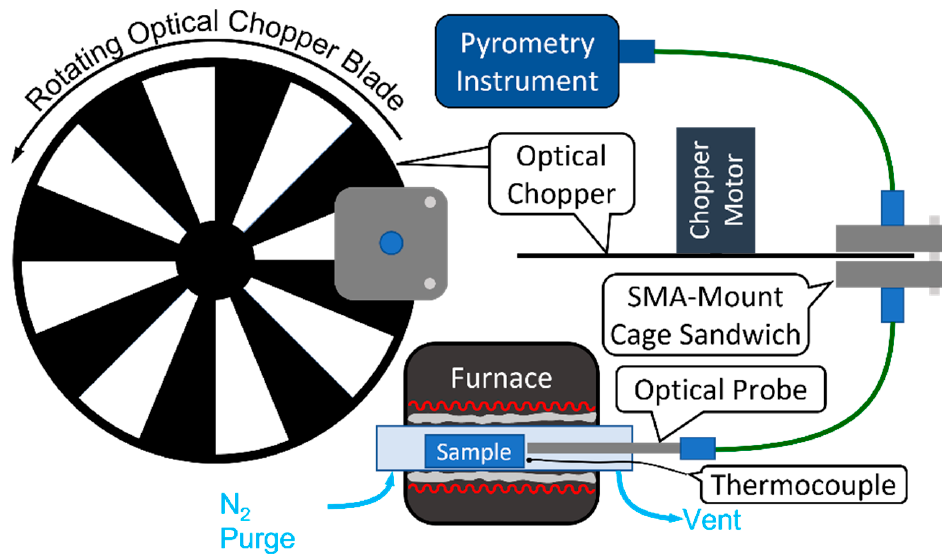
Figure 7. Schematic of laboratory bench setup for measuring surface temperatures of an LNF exhaust valve, and optical-chopper assembly for creating synthetic surface-emission transients to